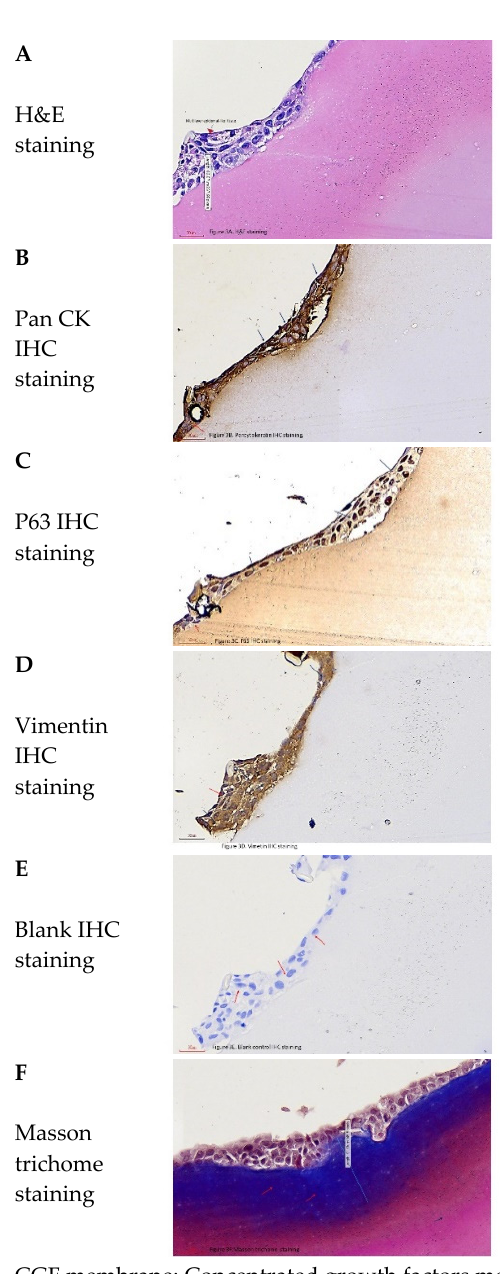
Figure 3. HaCaT cells were implanted on the concentrated growth factors membrane and cultured for four weeks. Multi-layer tissue was formed on the surface of the concentrated growth factors membrane. Tissue sections were prepared from these tissue samples from the in vitro culture preparation. Hematoxylin–eosin staining, pancytokeratin and P63 cell marker immunohistochemical staining were performed. The results were compared with those from blank controls. Figure 3A: After four weeks of in vitro culture, multi-layer tissue ( ) formed on the surface of the concentrated growth factors membrane. The maximal thickness was 74.05 µm ± 13.44 µm (mean ± SD) ( ). Figure 3B: The tissue sections of multi-